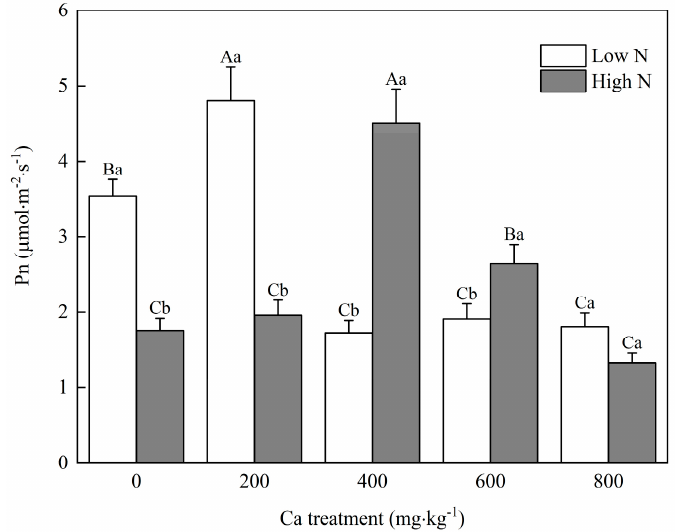
Figure 1. Effect of Ca treatments on the net photosynthetic rate of mulberry seedlings under different N levels. Capital letters denote significant differences among different Ca treatments within the same N level. Lowercase letters denote significant differences between the different N levels within the same Ca